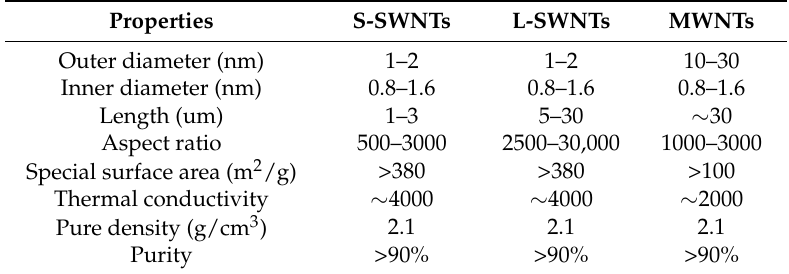
Table 2. Properties of carbon nanotubes (CNTs) [35]. S-SWNT: short single-walled nanotubes; L-SWNT: long single-walled nanotubes; MWNT: multi-walled